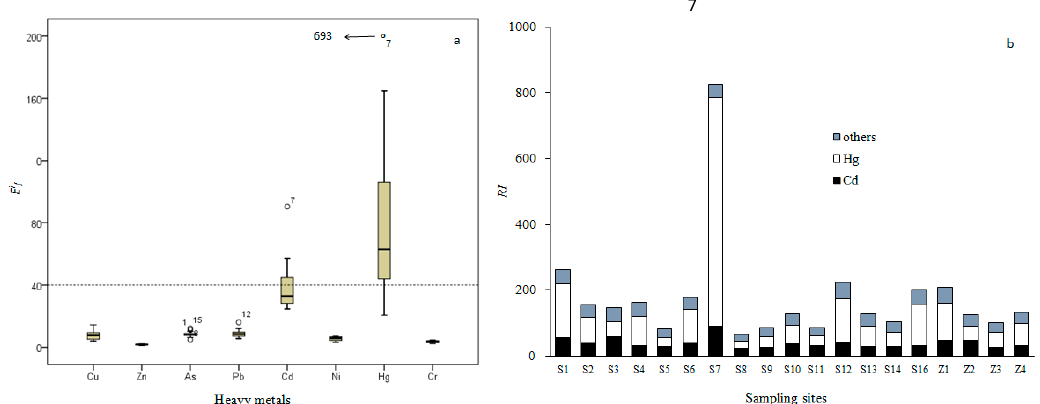
Figure 4. ( a ) Potential risk ( E i f ) of single metal and ( b ) integrated potential risk ( RI ) of different sampling sites in sediments of Daya Bay.